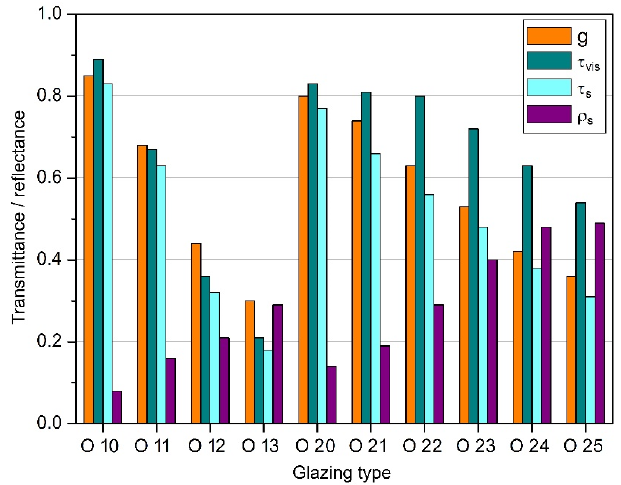
Figure 3. Optical parameters of glazing (based on [37]). To maximise passive gains, the balcony glazing was closed and exposed during the winter period. During the transitional period, it was possible to ventilate the balcony by opening the glazing, if the internal air temperature exceeded 22 °C. It was also assumed that overheating could be reduced by using curtains with a radiation transmittance of 50% if the internal temperature exceeded 24 °C or the intensity of solar radiation transmitted through the glazing exceeded 300 W/m 2 . The thresholds of ventilation and shading in res ‐ idential premises were assumed at the level of 24 °C and 25 °C, respectively. Taking into account changes in individual parameters, a total of 150 calculation cases, described in Table 2, were analysed. Table 2. The range of the basic parameters assumed in the simulations. Parameter